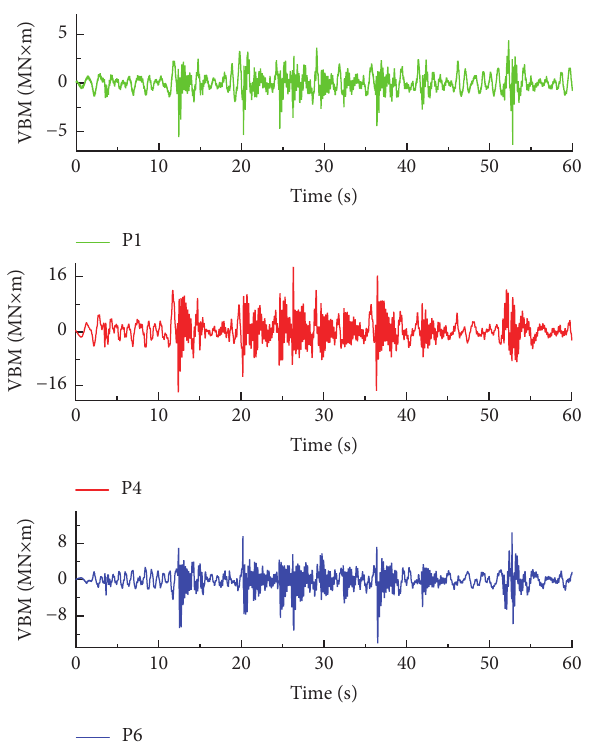
Figure 19: VBM time histories of main hull in beam